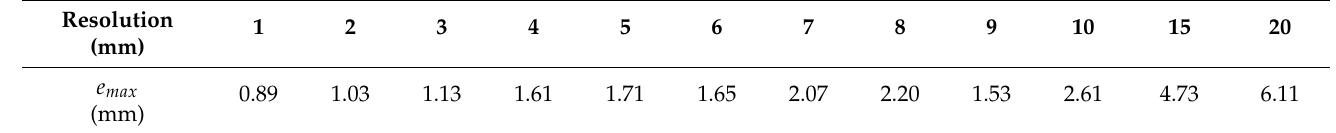
Table 6. The maximum vertex error for varying values of the lookup table